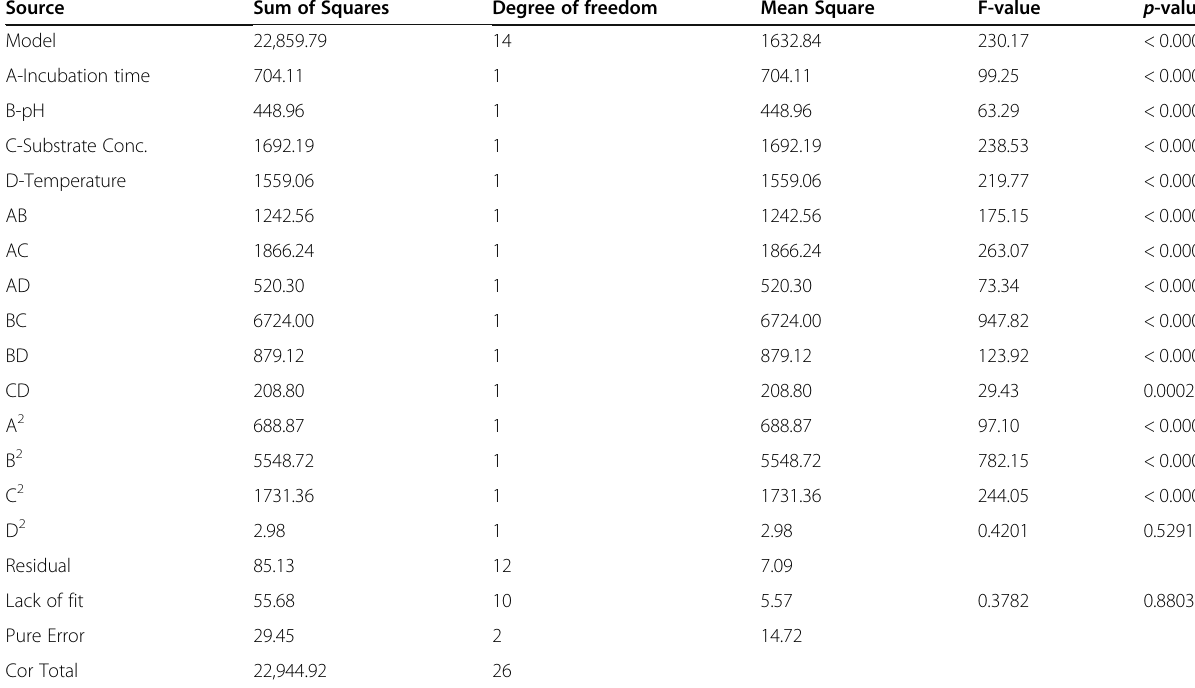
Table 5 Analysis of variance (ANOVA) for the quadratic model of xylanase enzyme activity as per Box-Behnken design Source Sum of